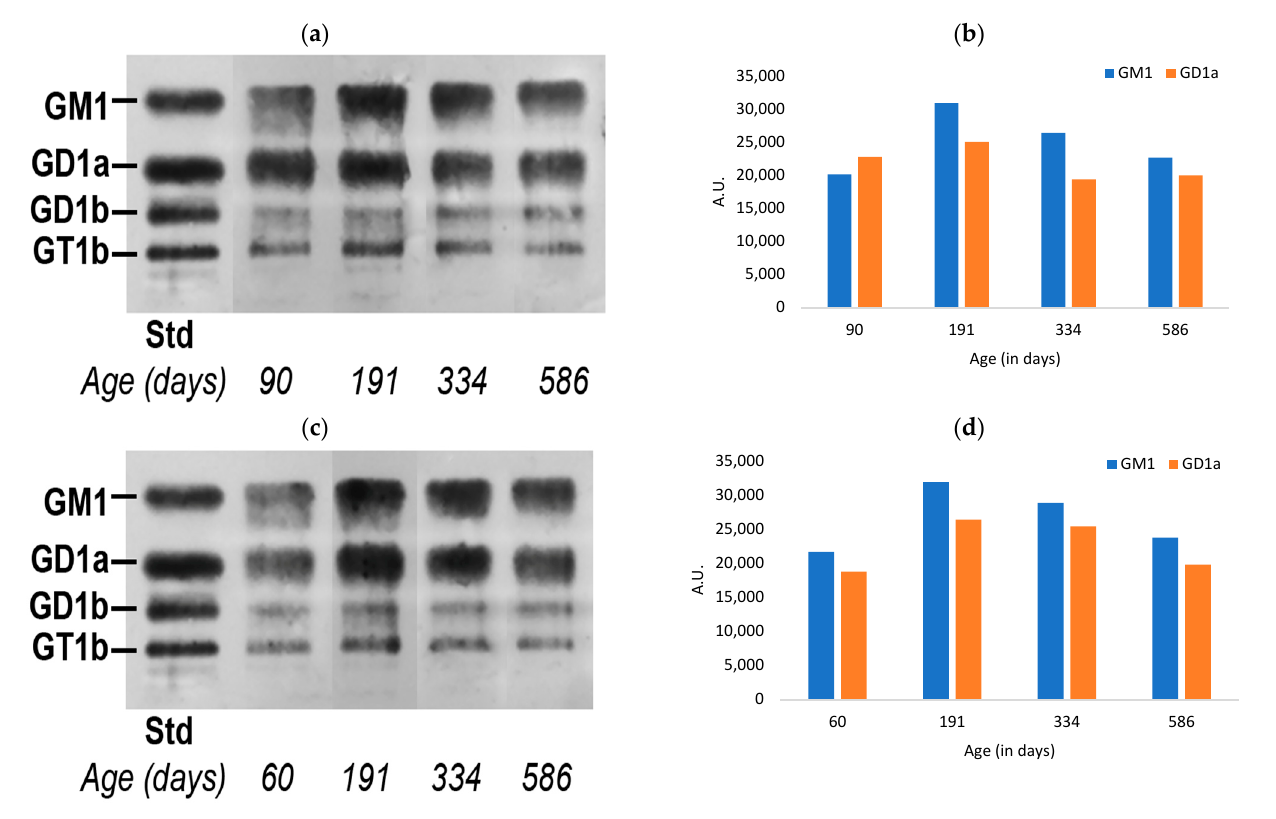
Figure 1. Quantification of a ‐ series gangliosides in the colon tissue of aging mice: ( a ) HPTLC of male mice colon gangliosides; ( b ) relative quantitation of the intensity of GM1 and GD1a; ( c ) HPTLC of female mice colon gangliosides; and ( d ) relative quantitation of the intensity of GM1 and GD1a (A.U. = arbitrary units).